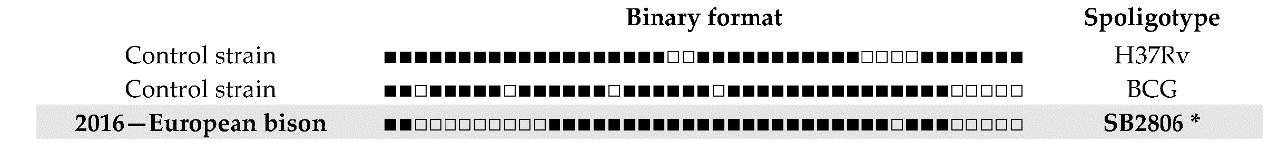
Figure 2. Spoligotyping results. Hybridization patterns (spoligotypes) of amplified mycobacterial DNAs of a strain isolated from European bison (*Assigned by www.Mbovis.org, accessed on 4 March 2023).